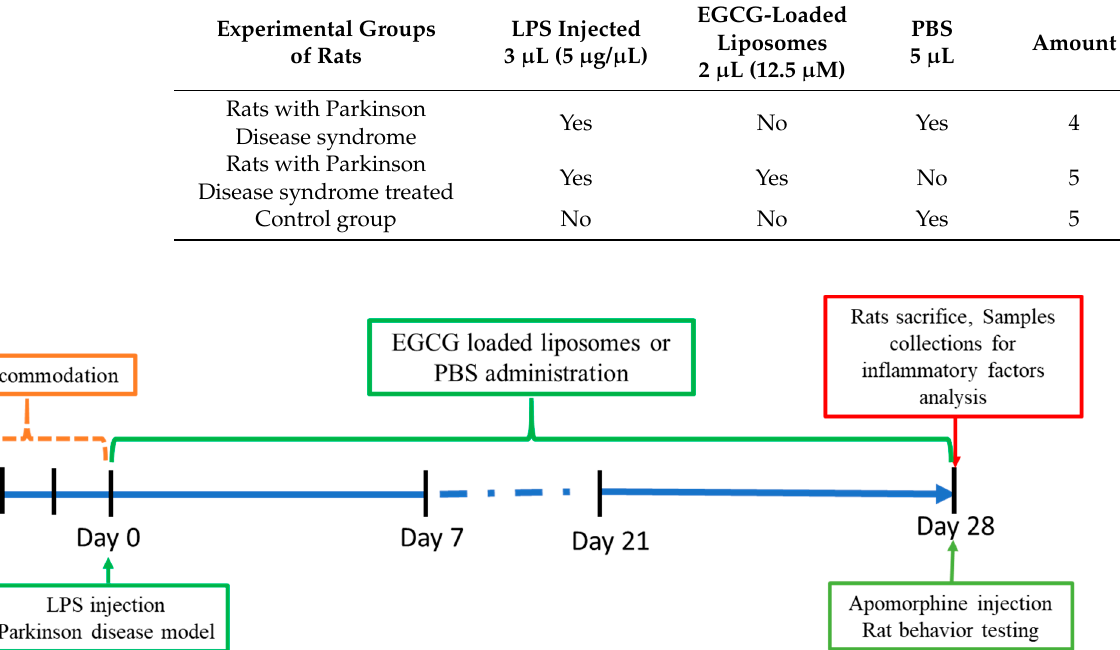
Figure 6. Experimental timeline of Parkinson’s disease model in rats treated with EGCG-loaded liposomes (or PBS).